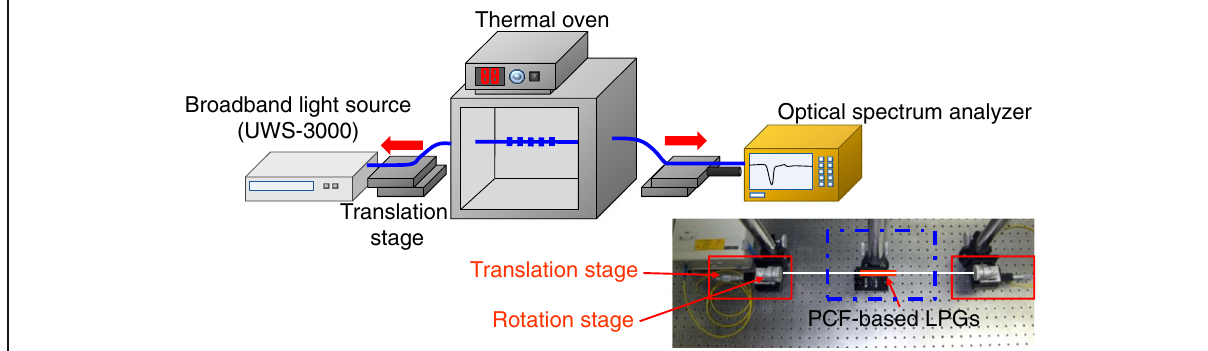
Fig. 3 Experimental setup for measurement of the transmission characteristics of the PCF-based LPG with periodic surface